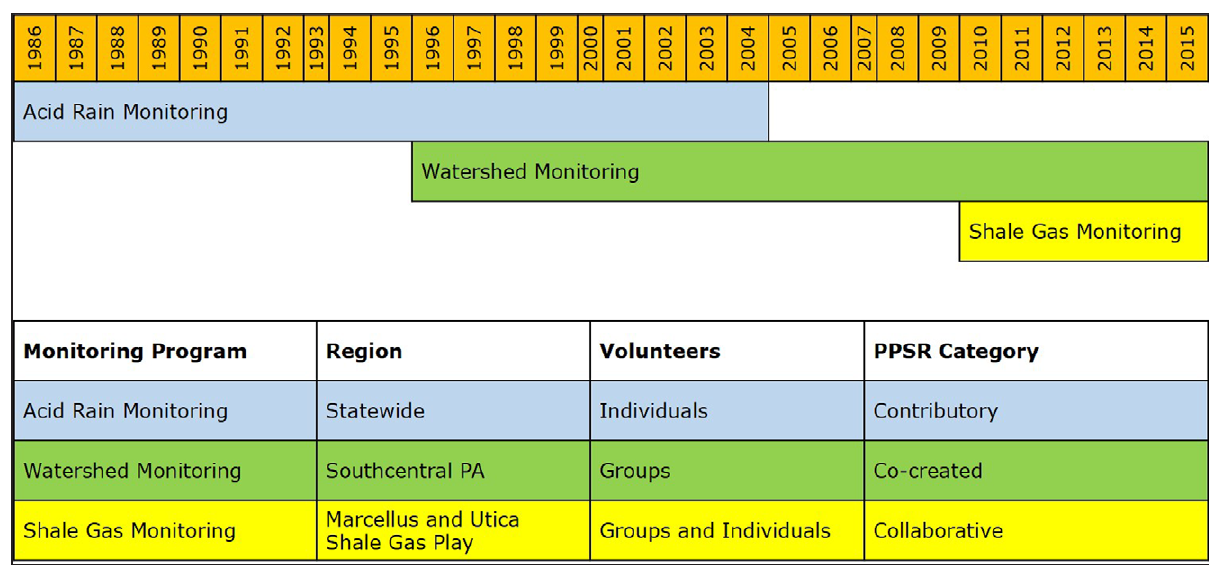
Figure 2: Timeline showing the history of ALLARM’s work with volunteers, using three different models for public participation in scientific